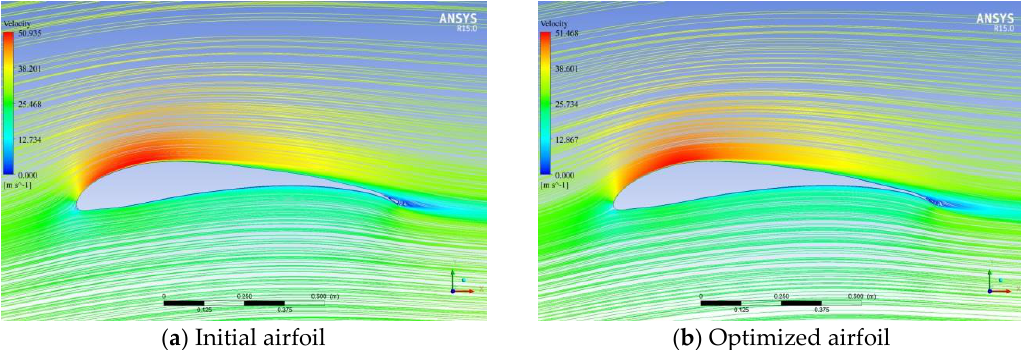
Figure 24. Velocity streamlines of the initial and optimized airfoils at α = 4°.